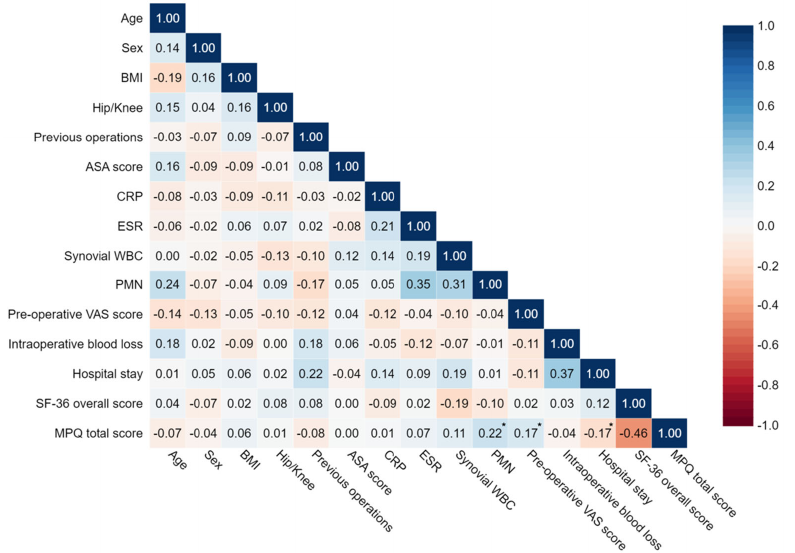
Figure 4. Correlation matrix of the potential risk factors for QOL and pain. (*: p < 0.05) .